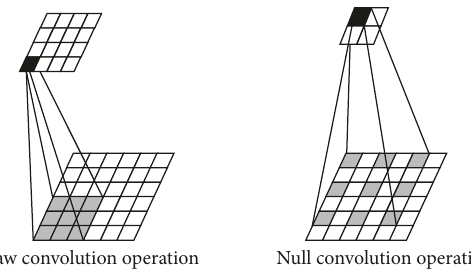
Figure 9: (a) Original convolution operation and (b) null convolution operation.